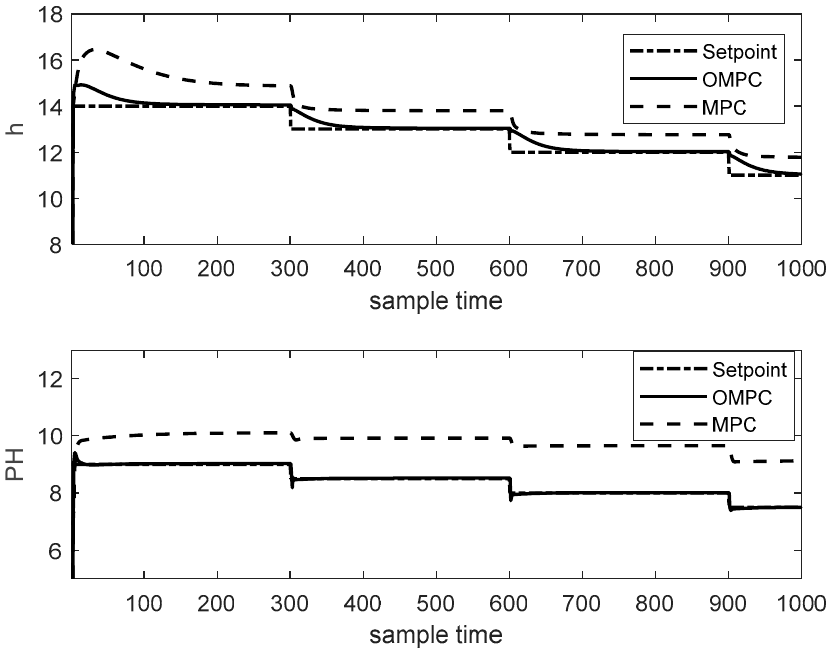
Figure 5. Comparison of the two control methods.